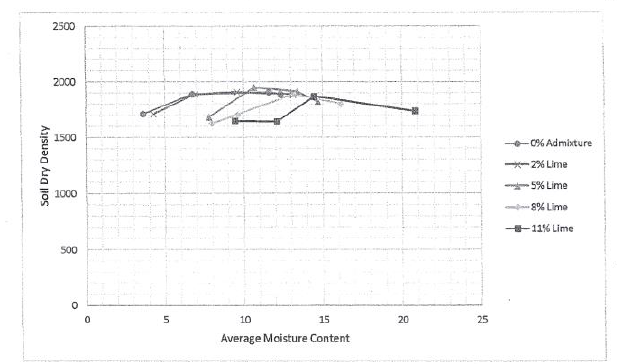
Figure 2: Particle Size Distribution Chart for Point 2